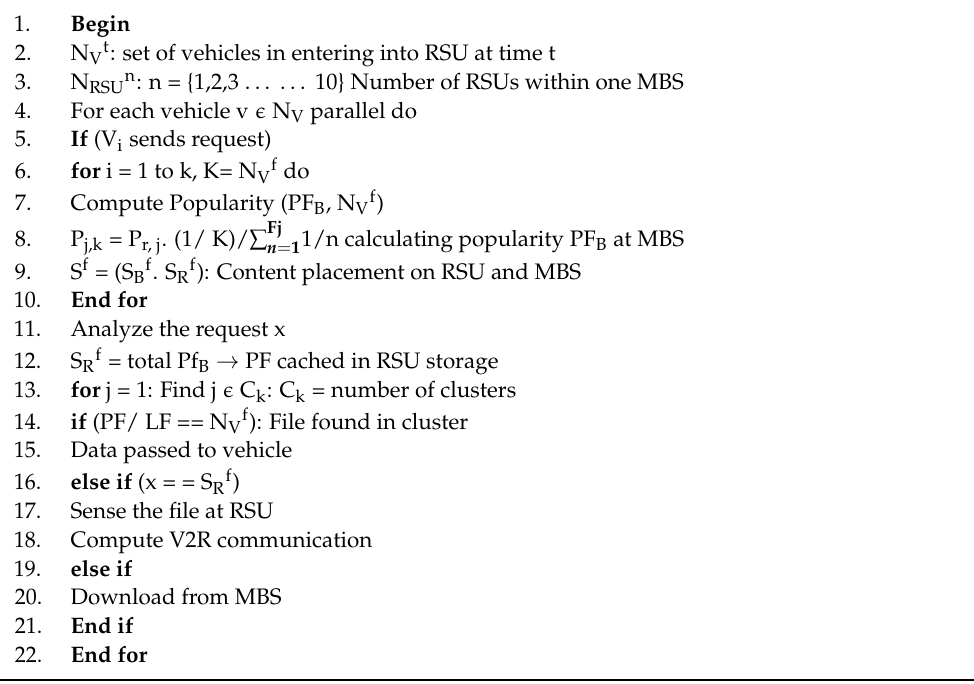
Algorithm 1: Cooperative Content Caching on MBS, RSU, and